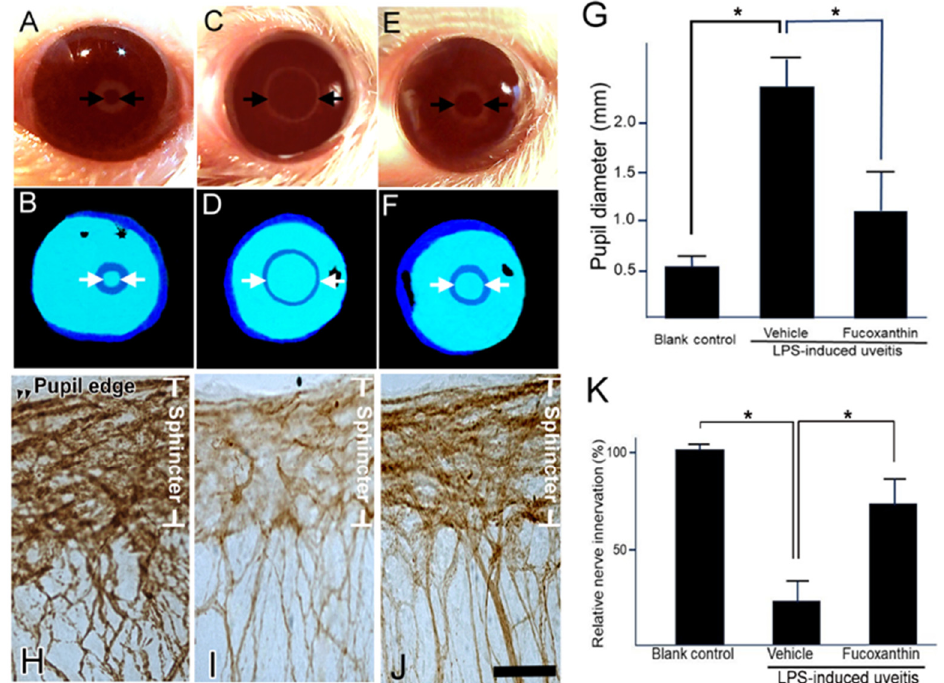
Figure 5. Protective effects of fucoxanthin on LPS-induced abnormal pupillary light reflex and denervation of the iris. The pupil diameter in response to pupillary light was compared among the blank control ( A , B ), LPS/vehicle ( C , D ), and LPS/10 mg/kg BW of fucoxanthin ( E , F ) groups. Abnormal pupillary light reflex was observed in the LPS/vehicle group relative to the control group, whereas the impaired reflex was alleviated in the LPS/10 mg/kg BW of fucoxanthin group ( G ). In addition, nerve innervation in the sphincter area was evaluated via immunohistochemical analysis of the general neural marker PGP 9.5. Nerve innervation was also compared among the blank control ( H ), LPS/vehicle ( I ), and LPS/fucoxanthin ( J ) groups. There was a significant reduction in nerve innervation in the sphincter muscle of the iris with evident LPS-induced nerve injury in the LPS-treated group ( I ) relative to in the blank control group ( H ), whereas nerve innervation was increased by treatment with fucoxanthin ( J ). Semi-quantification analysis of nerve innervation was calculated in the sphincter area and the results are presented as the mean ± SD ( n = 5). Denervation in the sphincter region of the iris was reduced in the 10 mg/kg BW of fucoxanthin pretreatment group as compared to the LPS group ( K ). * p < 0.05: Compared to the LPS/vehicle group (Student’s t -test). Scale bars: 50 µ